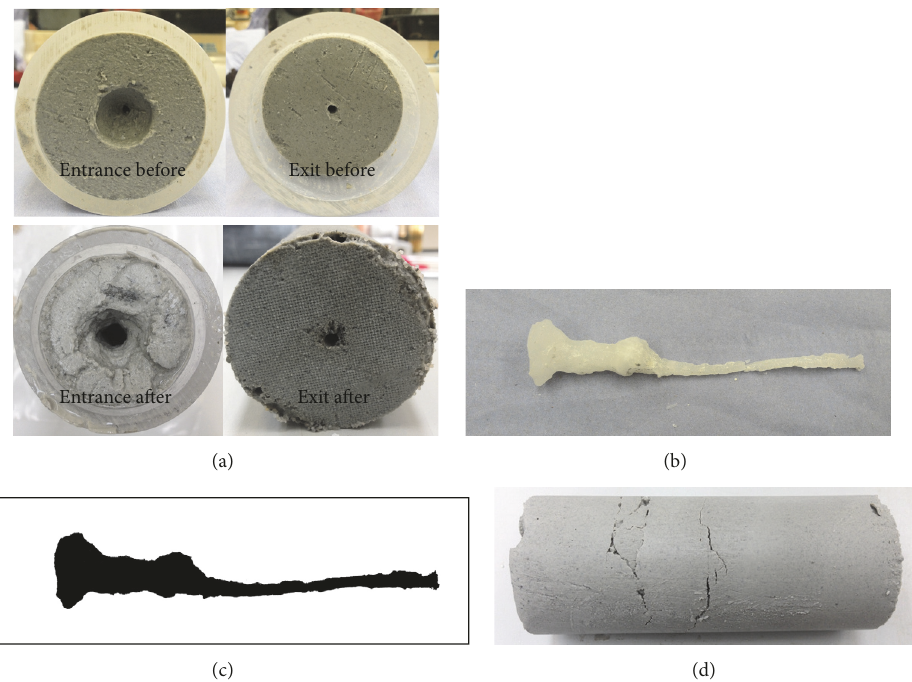
Figure 4: Example of the 14 days CB-PFA sample being eroded for 2 hours. (a) Surfaces of entrance and exit of the hole before and after test; (b) cast of the eroded cavity; (c) extracted black silhouette of the cast; (d) brittle transverse microcracks appeared during eroding. When erosion time increased to 3 hours, all test specimens indicated